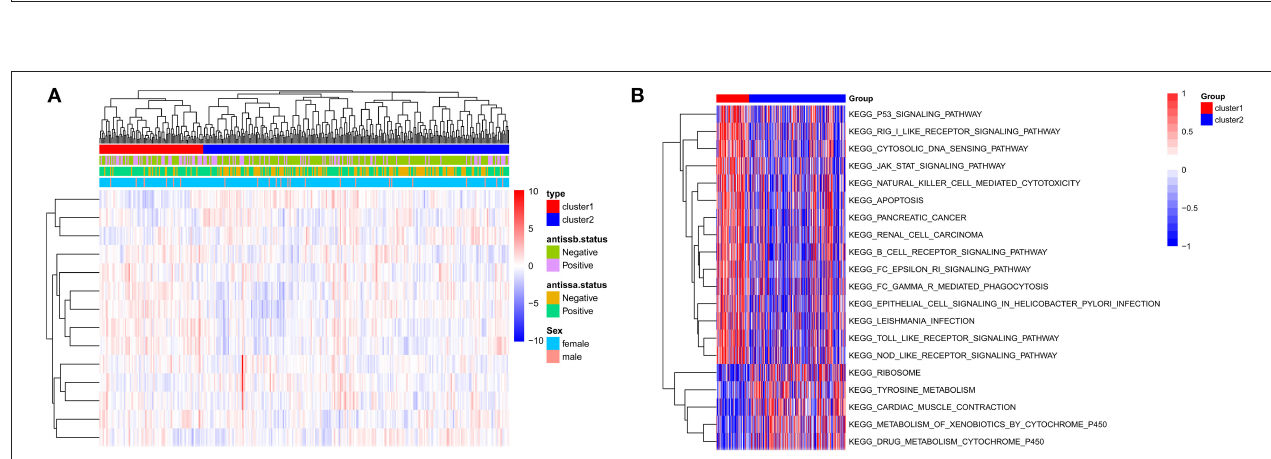
FIGURE 6 | Identification of subtypes based on the GSE140161 dataset. (A) Heatmap of subtypes and clinical information. (B) Gene set enrichment analysis of genes in the two subtypes.